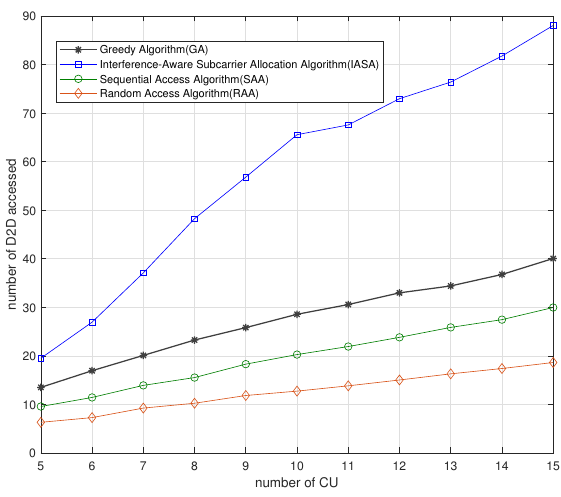
Figure 3. Number of mMTC pairs accessed versus different eMBB devices using different algorithms.